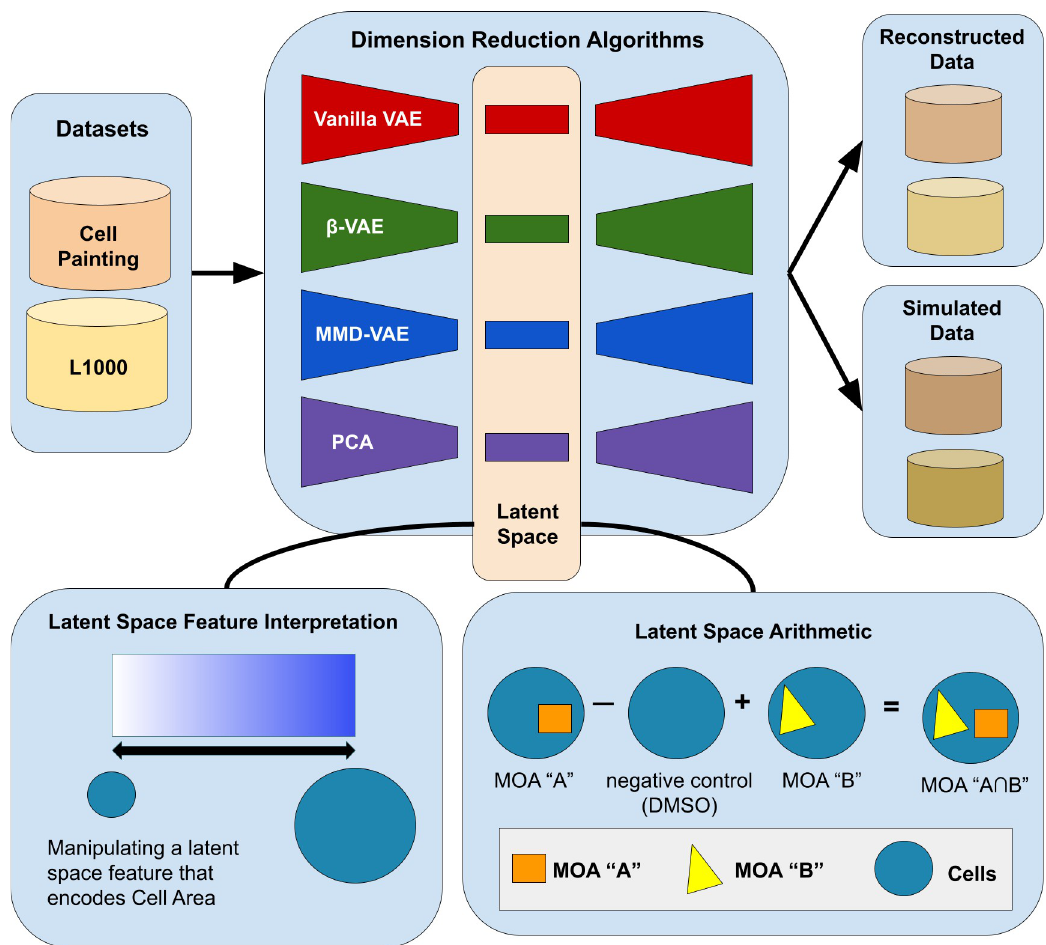
Fig 1. Our variational autoencoder (VAE) implementation framework, applied to determining the phenotype of cells. One application is to predict the phenotype of cells treated with compounds that have two mechanisms of actions (MOA), given the phenotype of cells treated with compounds that have each of those single MOAs (bottom right). A VAE encodes input data into a lower-dimensional latent space and then decodes the representation back into the original data dimensions. Our data contained measurements for 588 morphology features, each averaged for each population of cells treated with a given chemical compound. Following a sweep to select optimal hyperparameters (see Methods), we set our latent space dimension to 10 dimensions. The vanilla VAE learns by minimizing a reconstruction and KL-divergence loss. The other VAE variants we tested minimize loss functions that encourage disentangled features that promote interpretability, data simulation, and enable meaningful LSA.